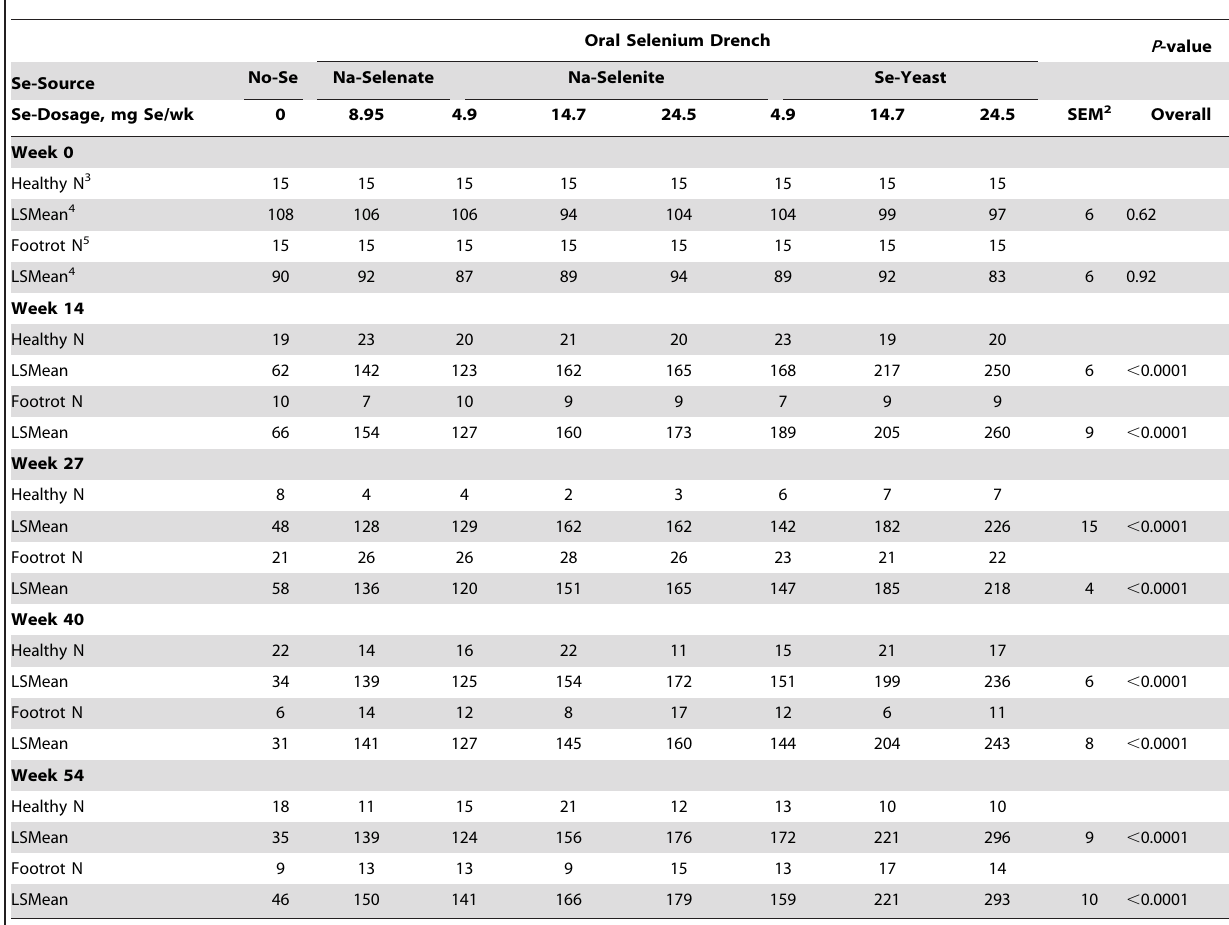
Table 2. Serum-Se concentrations (ng/mL) in ewes after weekly oral drenching with no Se, inorganic Se (Na-selenate or Na- selenite), and organic Se (Se-yeast) at varying supplementation rates (4.9, 14.7, and 24.5 mg Se/wk; Na-selenate only at 8.95 mg Se/ wk) for 62 wk.